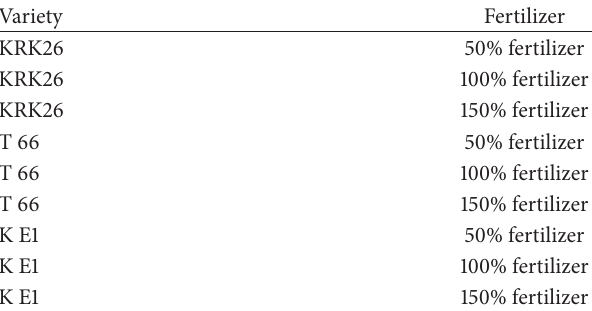
Table 2: Variety and fertilizer treatments.